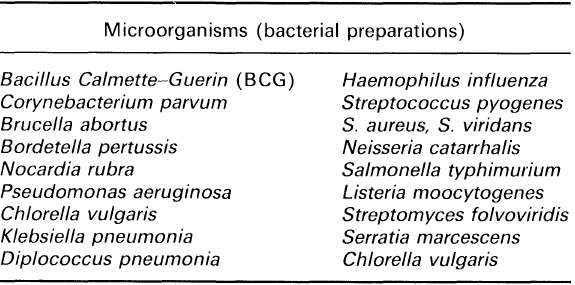
Table 1. Biological response modifiers of biological origin Microorganisms (bacterial preparations)